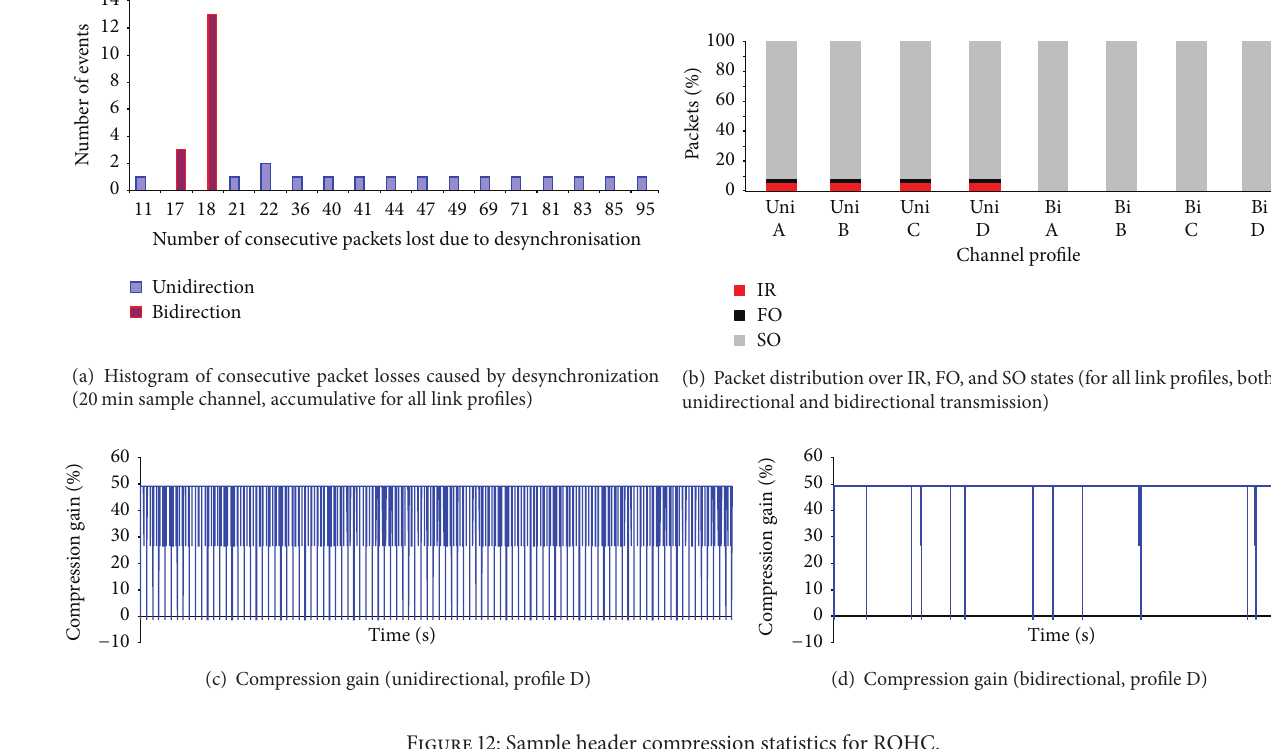
Figure 12: Sample header compression statistics for ROHC.